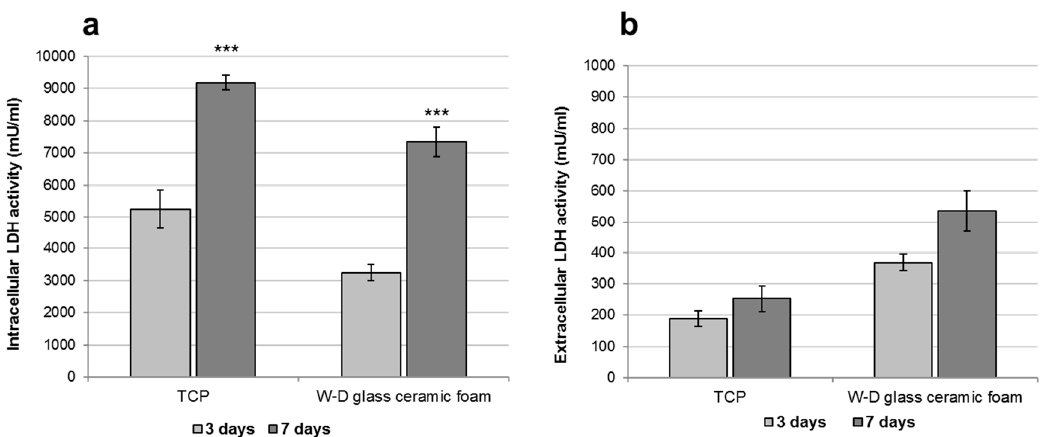
Figure 10. LDH activity assay of fibroblasts cultured on TCP (control condition) or on W-D glass-ceramic foam for three and seven days. ( a ) Intracellular LDH activity; ( b ) Extracellular LDH activity. Significant difference * ( p < 0.05); ** ( p < 0.01); *** ( p < 0.001).